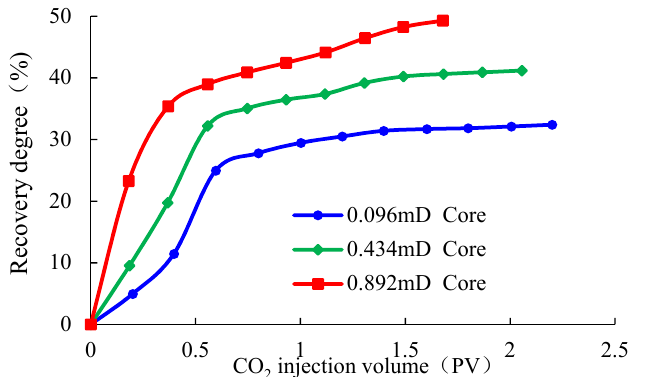
Figure 8. The recovery degree of cores with different permeability under immiscible conditions.